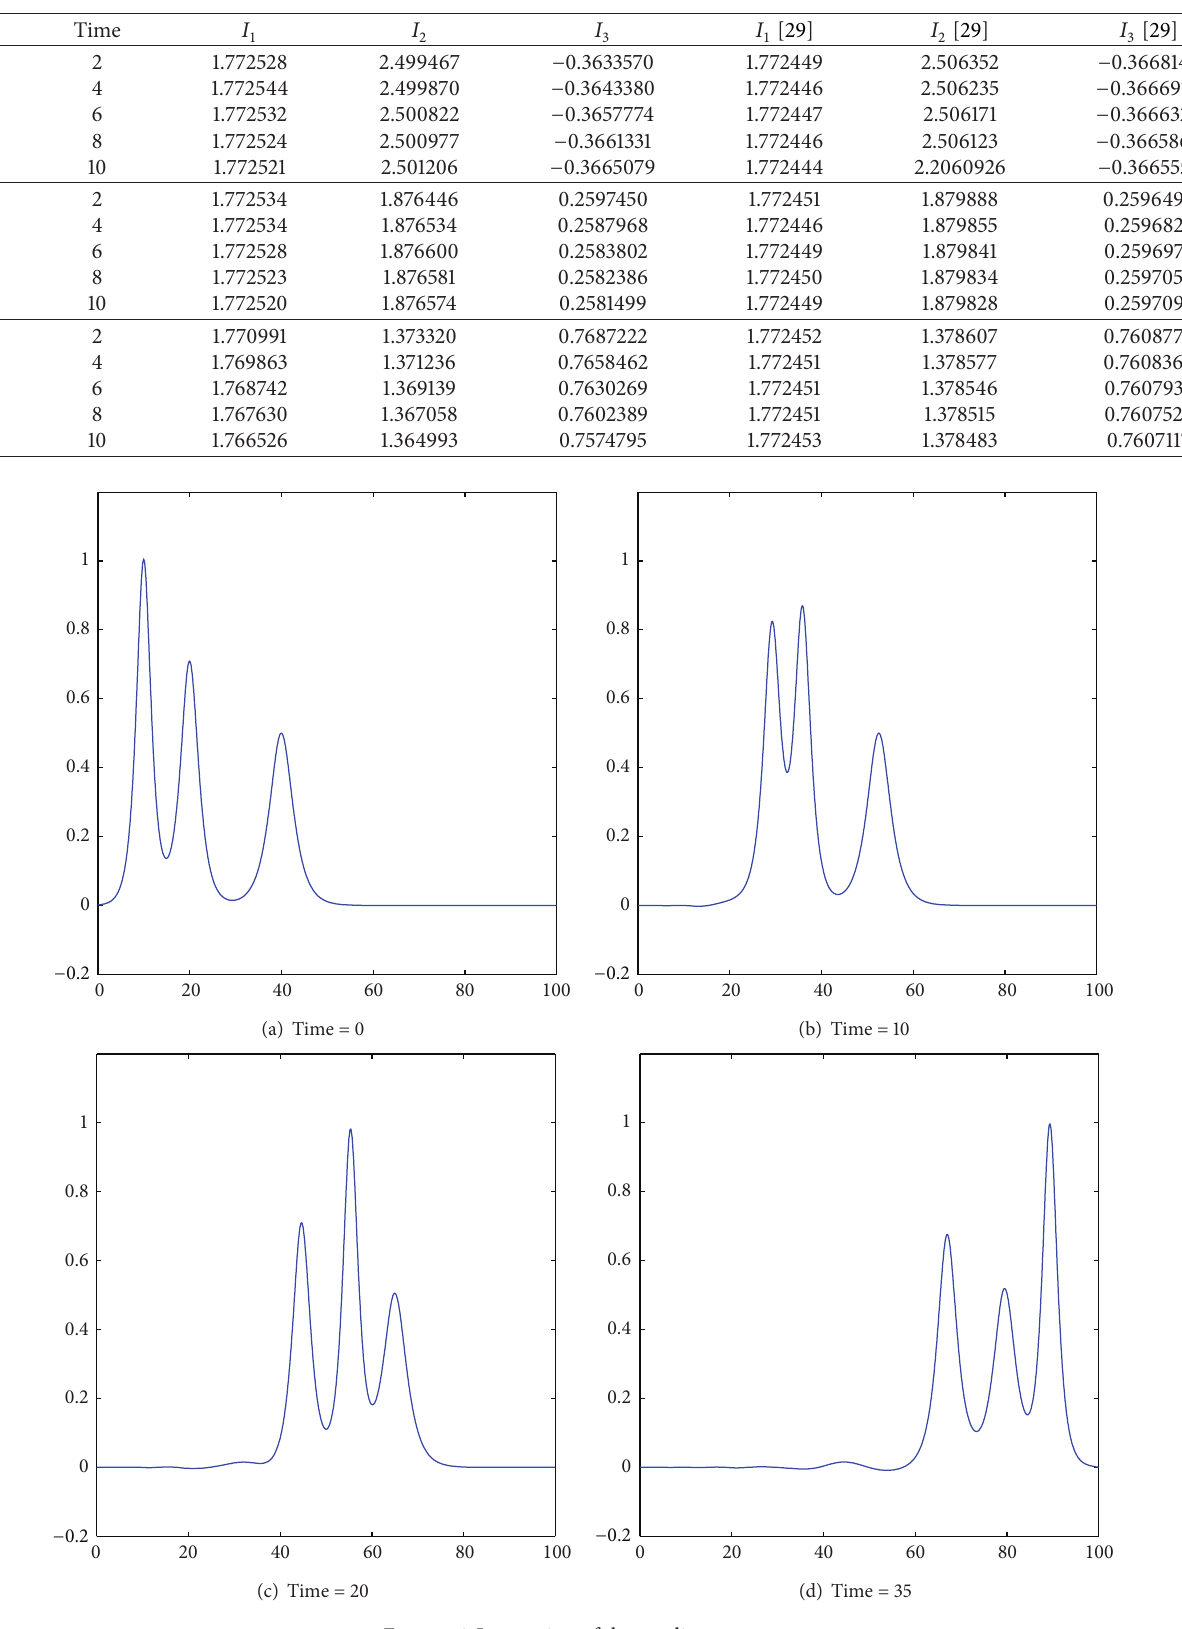
Figure 6: Interaction of three solitary